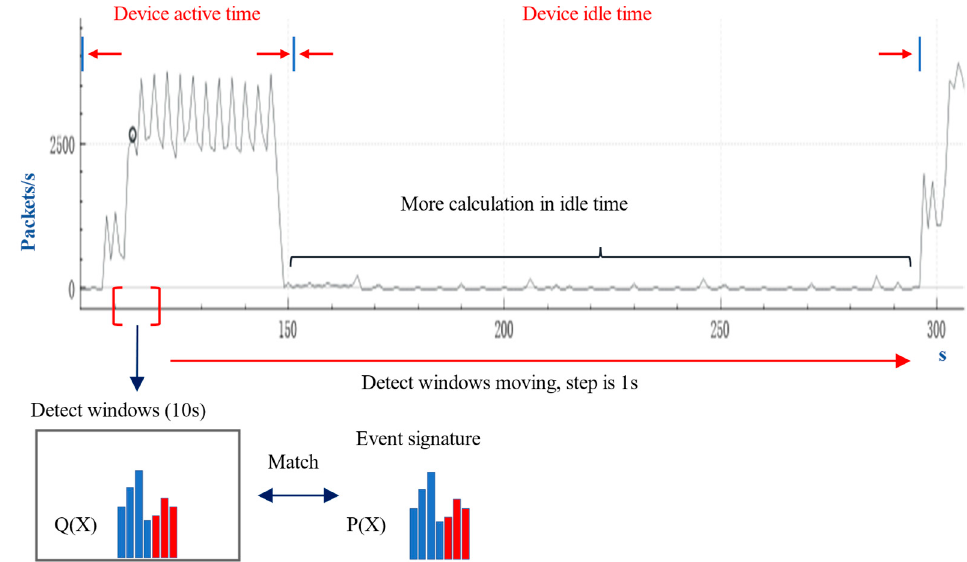
Figure 4. Signature detection process in PINBALL.